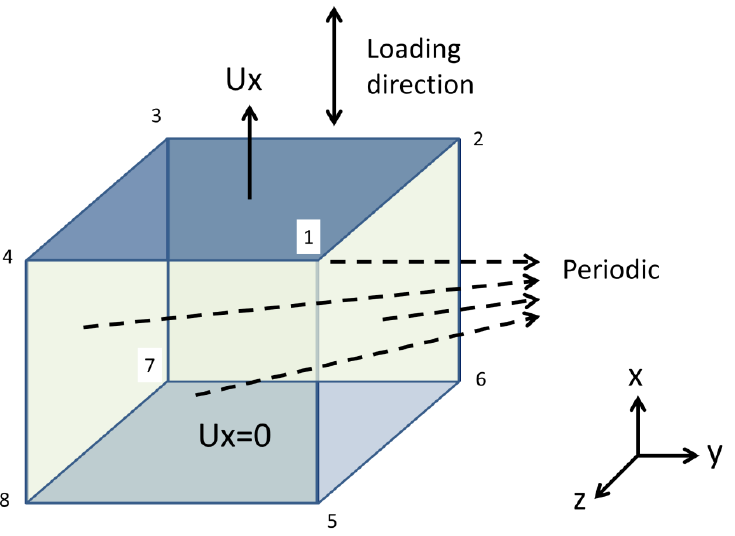
Figure 5. Boundary conditions for the representative volume elements (RVEs): (1—2—3—4): U x